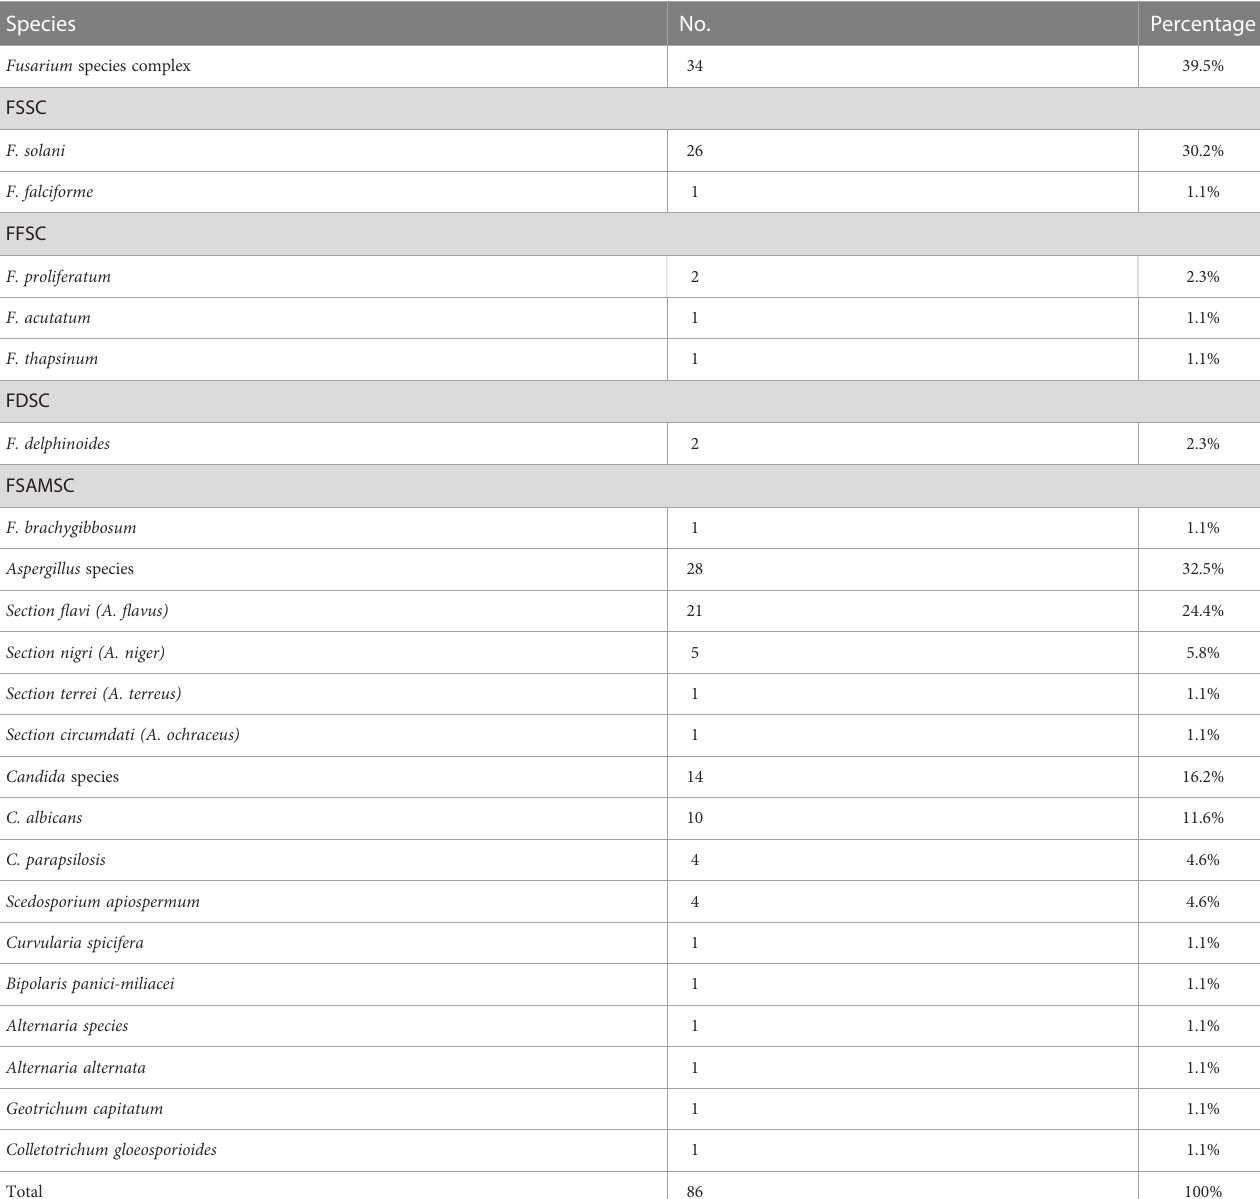
TABLE 3 Fungal pathogens isolated from 86 cases of fungal keratitis.